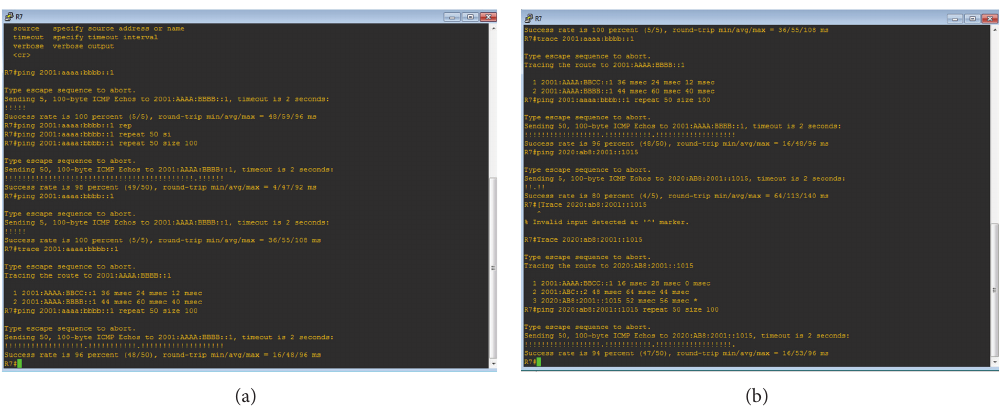
Figure 4: Ping, traceroute, and weighted pinging response of IPv6 network. (a) Asymmetric NAT in MST. (b) Symmetric NAT in MST.